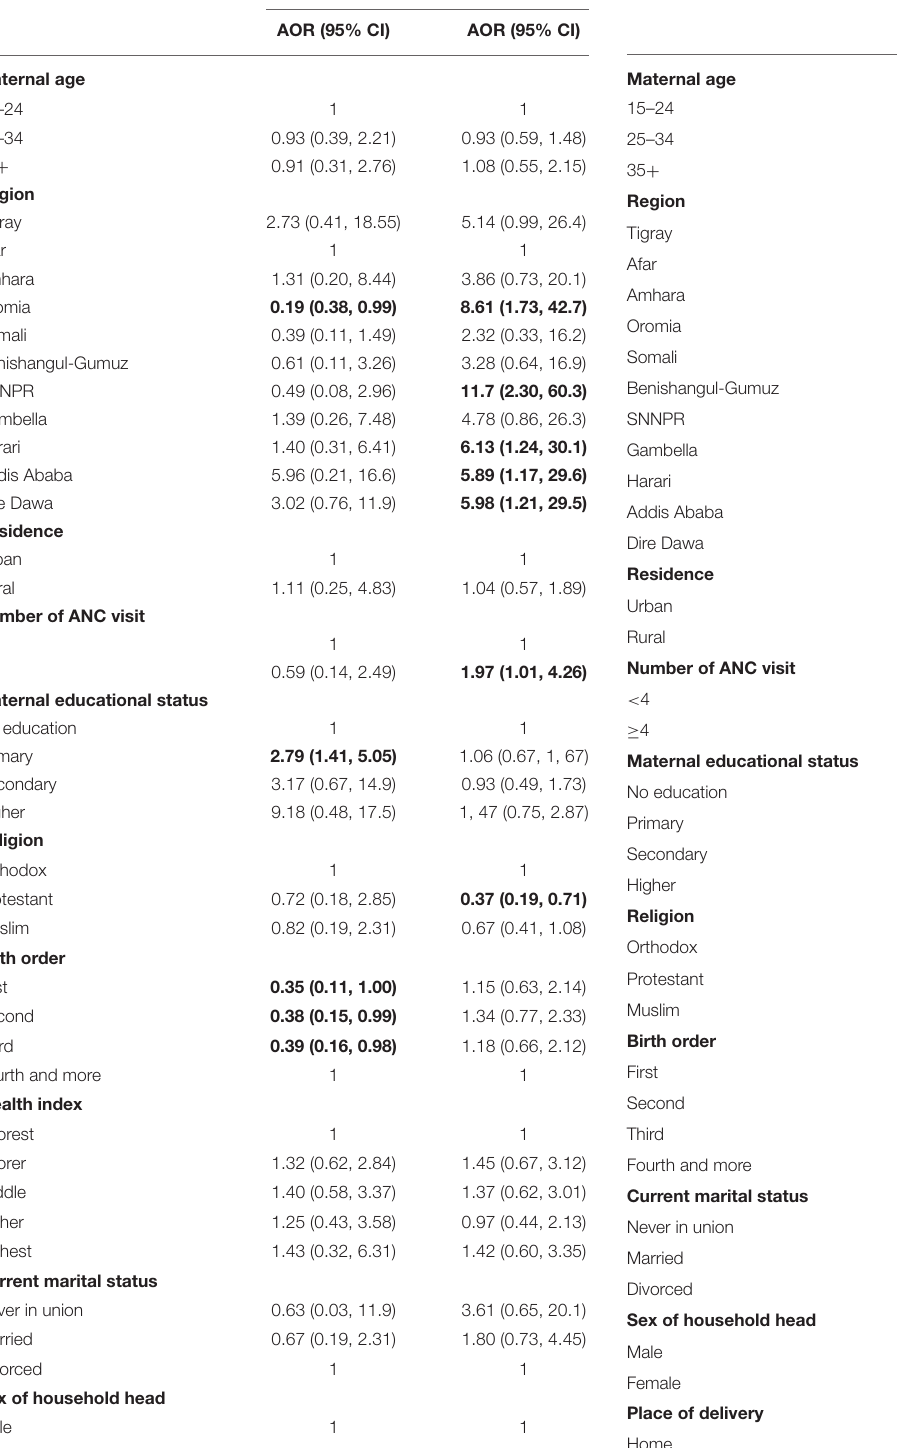
TABLE 2 | Multivariable mixed-effect logistic regression analysis of any postnatal care among newborns by place of delivery in Ethiopia, 2019. Variables